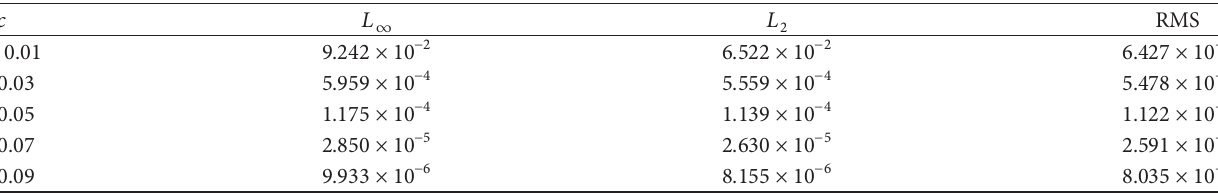
Table 2: Numerical errors using IMQ represented with different parameter 𝑐 at time 𝑡 = 3 , where 𝑑𝑥 = 0.01 , 𝑑𝑡 = 0.001 , and 𝜃 = 1/2 .